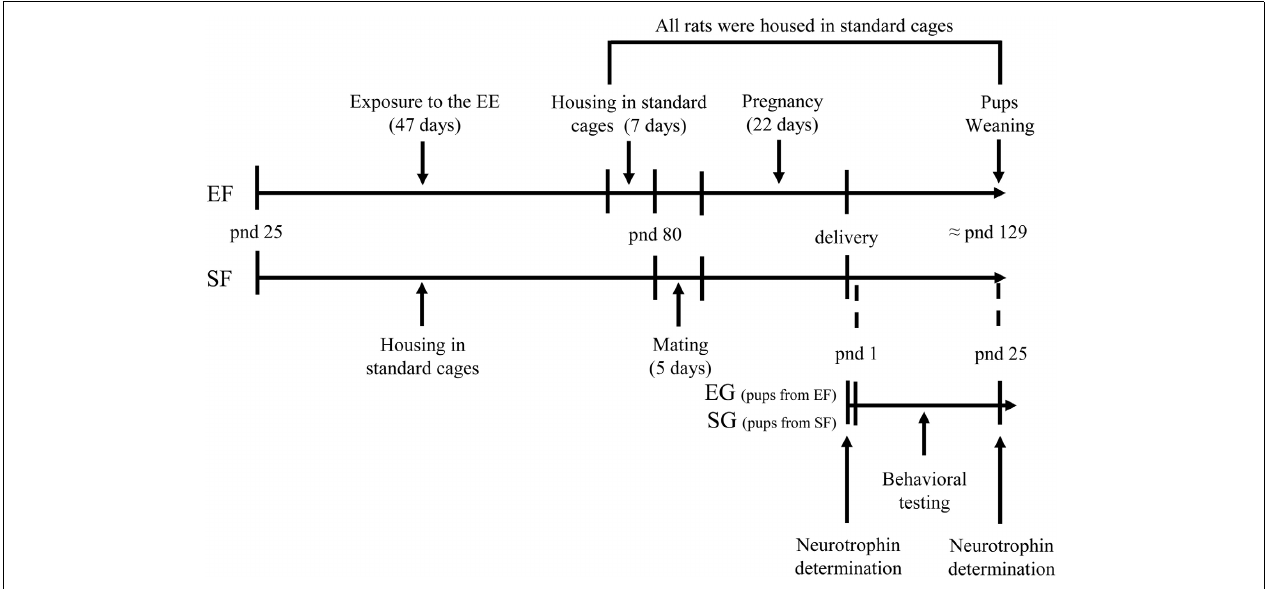
FIGURE 1 | Timeline of the experimental procedure. Experimental groups of female rats according to different pre-reproductive rearing conditions (EF, enriched females; SF, standard females. Duration: ≈ 7 weeks). Experimental